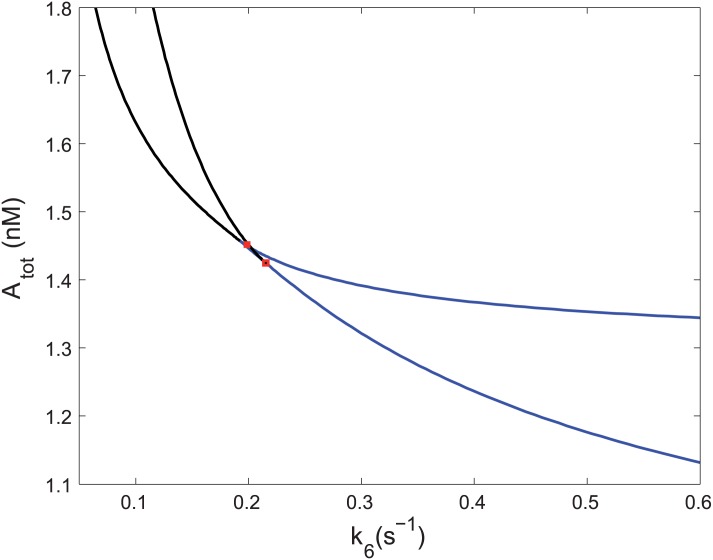
Bifurcation diagram in the parameter plane Atot vs k6.Values of fixed parameters are given in the text. Blue curve—saddle-node bifurcation delimiting region of three steady states, black curve—Hopf bifurcation, red square—Bogdanov-Takens point.